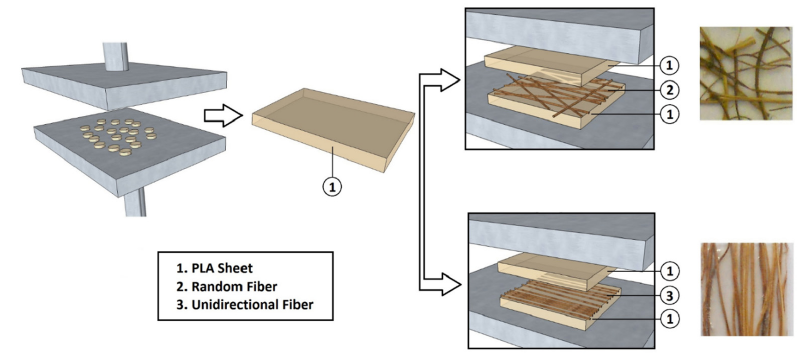
Figure 1. Scheme of the manufacturing process to obtain PLA sheets and PLA/artichoke fiber